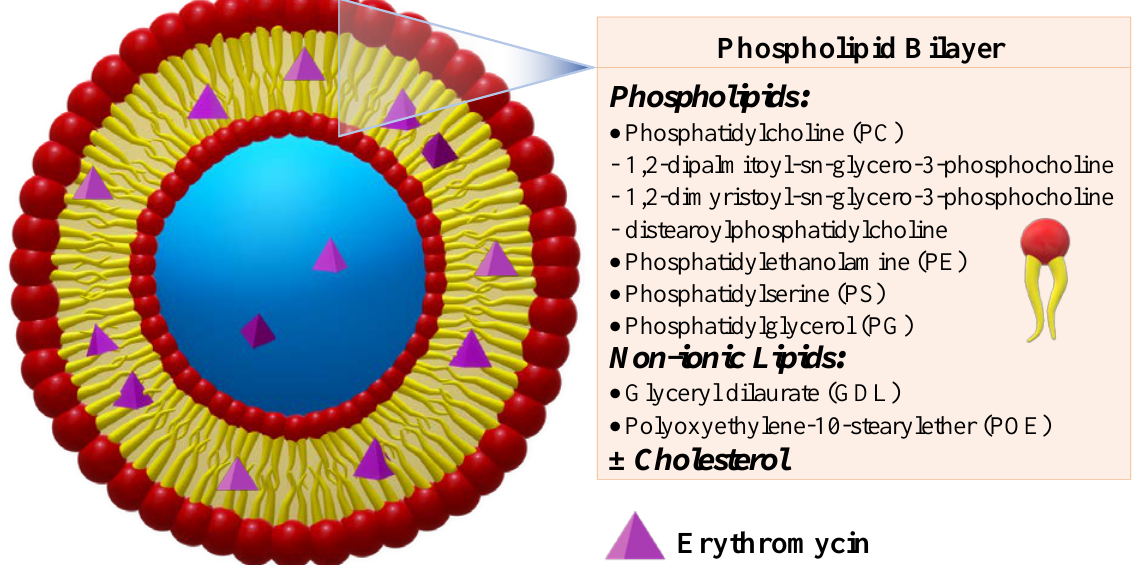
Figure 2. Schematic representation of an ERY unilamelar liposome. ERY has very low water solubility, yet some drug molecules can possibly enter the aqueous compartment.